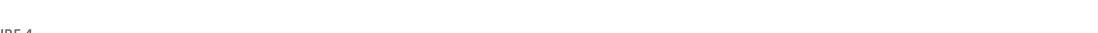
FIGURE4 Different lowercase letters in the heatmap indicate significant differences among different plant species and different spatial parts of the MCB based on a one-way ANOVA with LSD multiple comparisons at P < 0.05. (B) Principal coordinate analysis (PCoA) plot of the bacterial community based on Bray–Curtis distance on operational taxonomic unit (OTU) level. Analysis of similarity (ANOSIM) of bacterial community among different groups based on Bray–Curtis distance with 999 permutations. Left plot is species-specific color-coded while right plot is color-coded for MCB area. Round marks: bulk samples, marks of rhombus shape: rhizosphere samples. (C) Linear discriminant analysis effect size (LEfSe) of bacterial communities between bulk and rhizosphere soils. Bacteria with linear discriminant analysis (LDA) scores > 3.0 are displayed in LEfSe cladogram. Circles in LEfSe indicate phylogenetic levels from order to genus, and only bacteria at genus level are labeled with taxonomy. The diameter of each circle is proportional to the abundance of the group. Rhizo, rhizosphere; Pc, P. communis ; Cd, C. dactylon ;